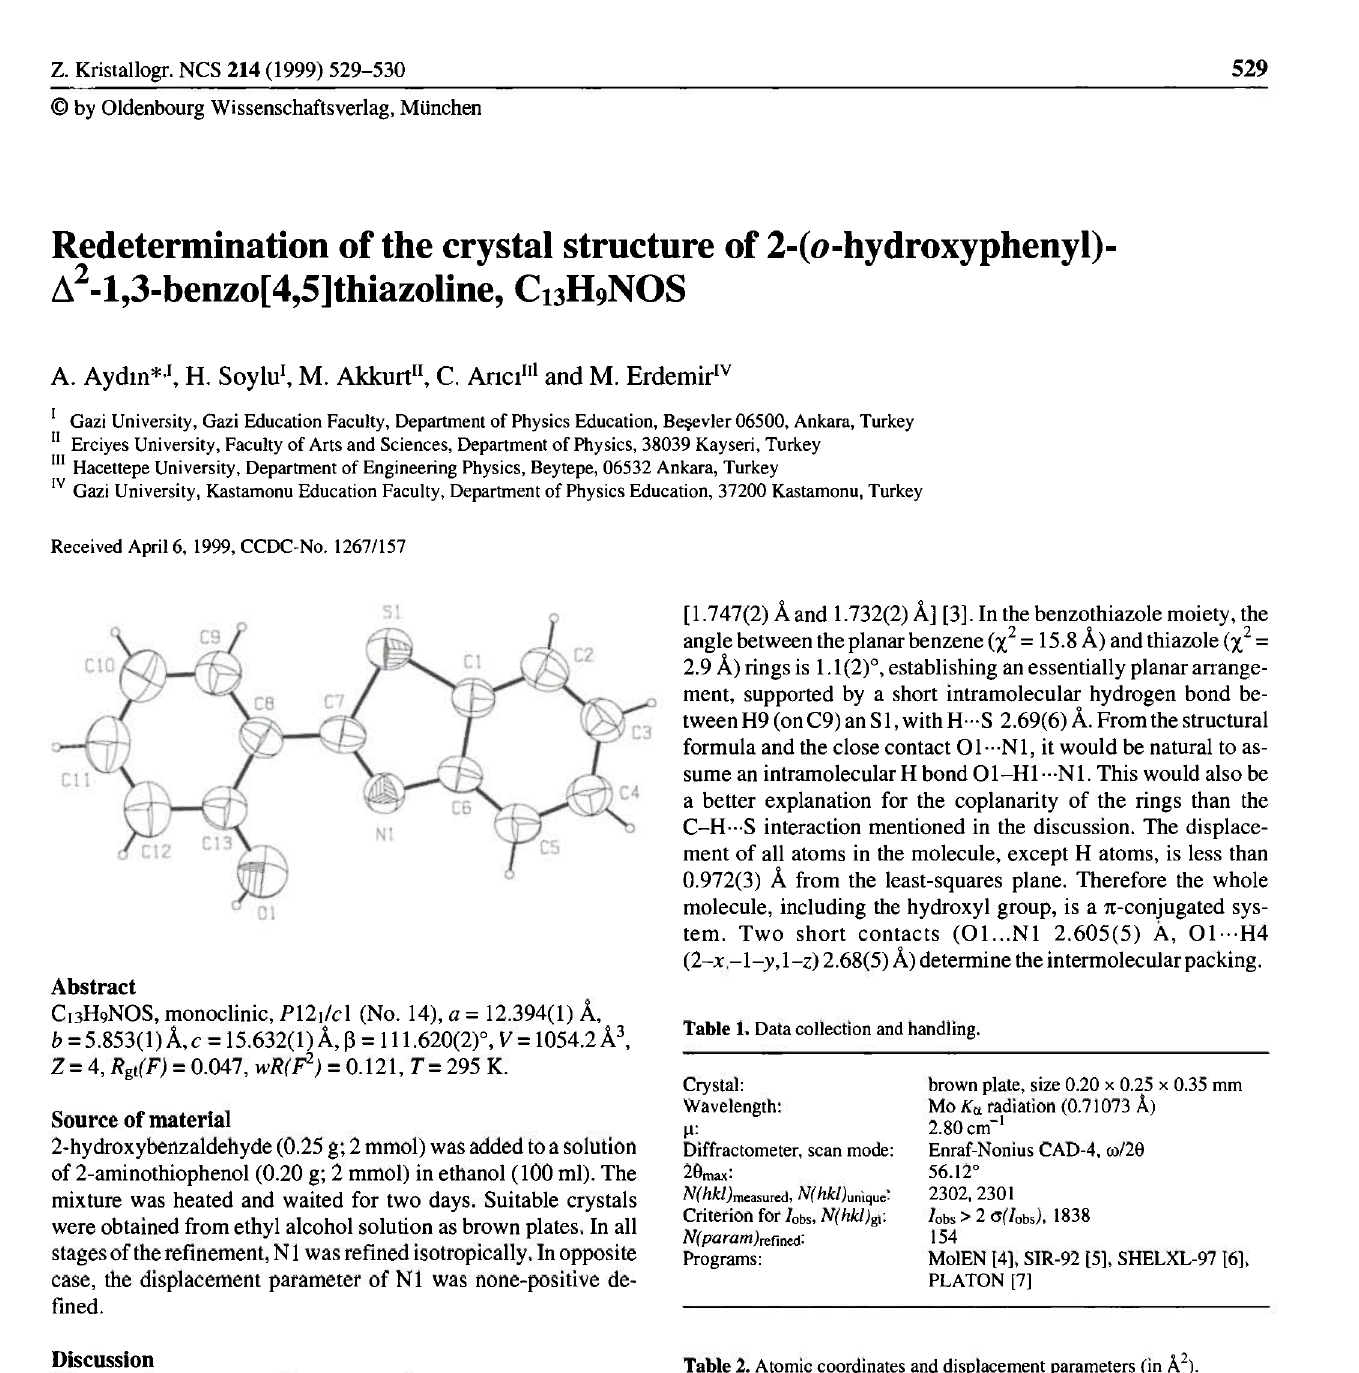
Table 2. Atomic coordinates and displacement parameters (in Ä 2